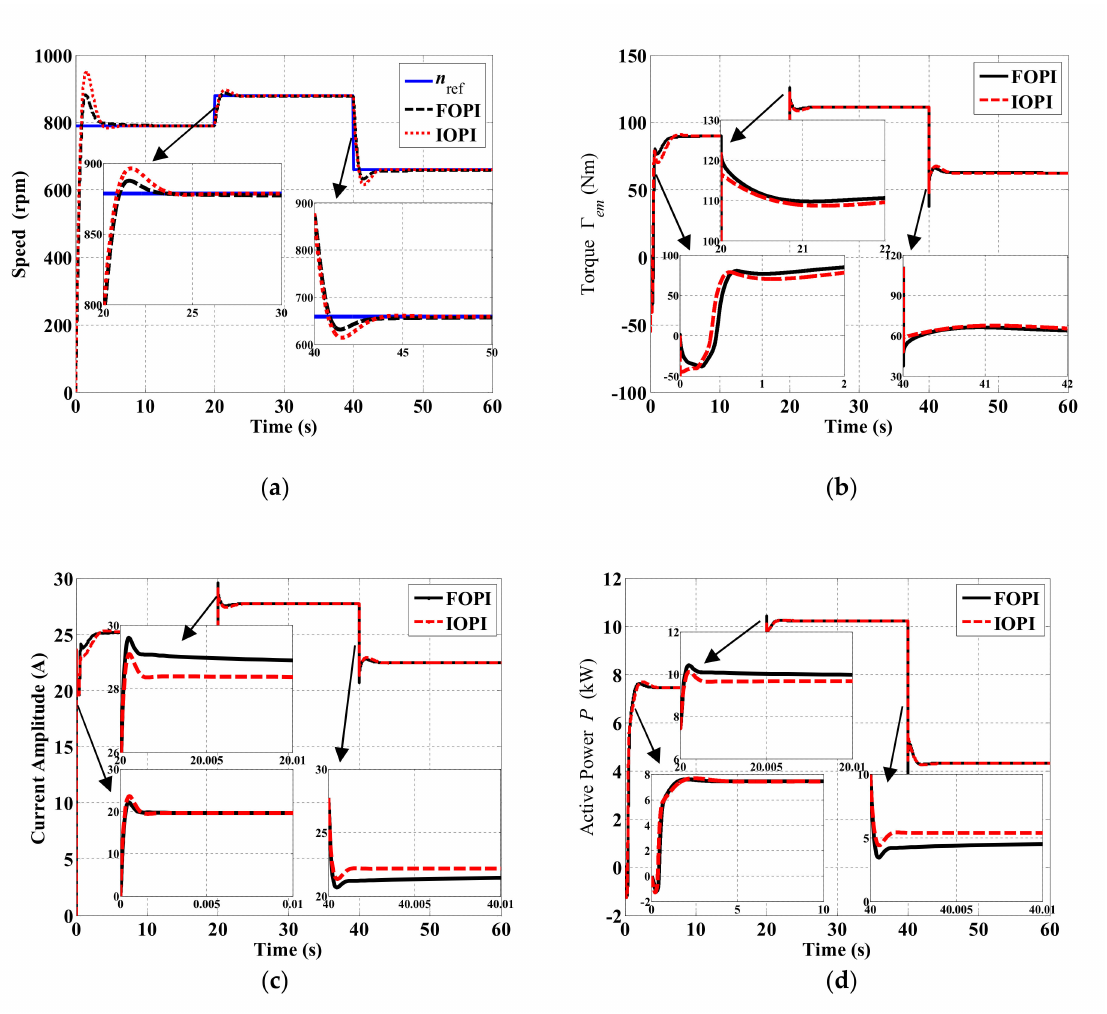
Figure 9. Performance of DFIG for FOPI and IOPI controllers with variable marine tidal current speed: ( a ) DFIG speed; ( b ) electromagnetic torque; ( c ) rotor current amplitude; ( d ) active